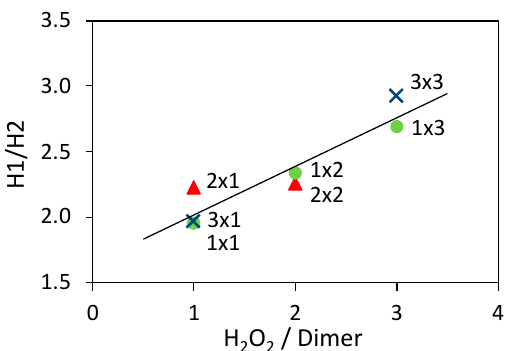
Figure 5. Dependence of the H1/H2 ratio from the H 2 O 2 /aniline dimer molar ratio. Samples prepared using the same TiO 2 amount are represented with the same marker and the line is added as guide for the eyes.